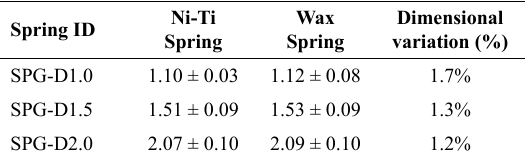
Table 3. Dimensional verification of the spring wire diameter ( d ).